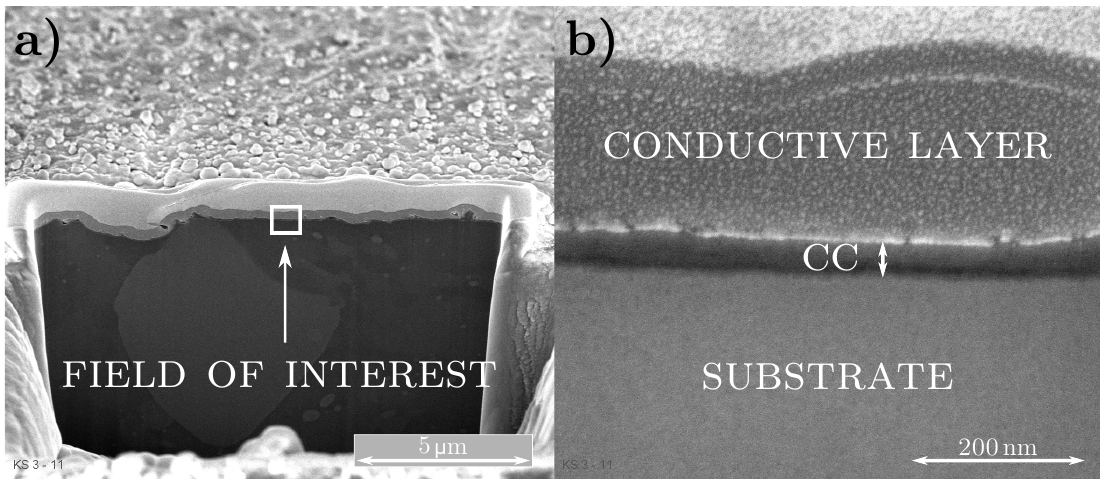
Figure 4. Scanning electron microscope (SEM) images of specimen PT5, ( a ) macroscopic view and ( b ) zooming in the area marked by the white rectangle.